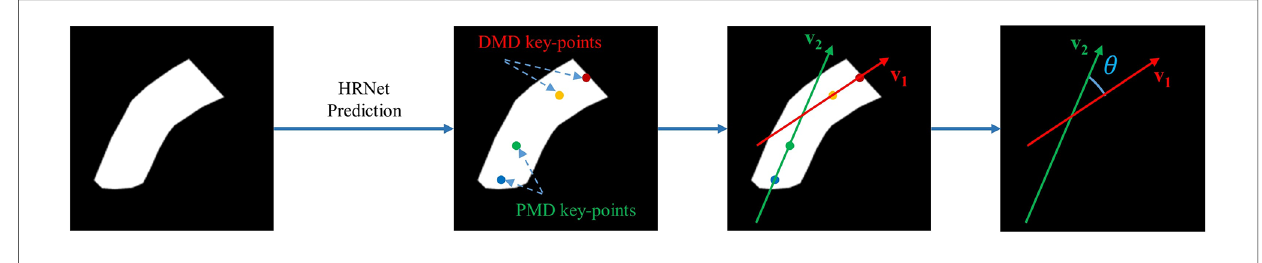
FIGURE 7 Angle calculation process using 4 predicted key points (distal mid-axis dots, DMD; and proximal mid-axis dots,